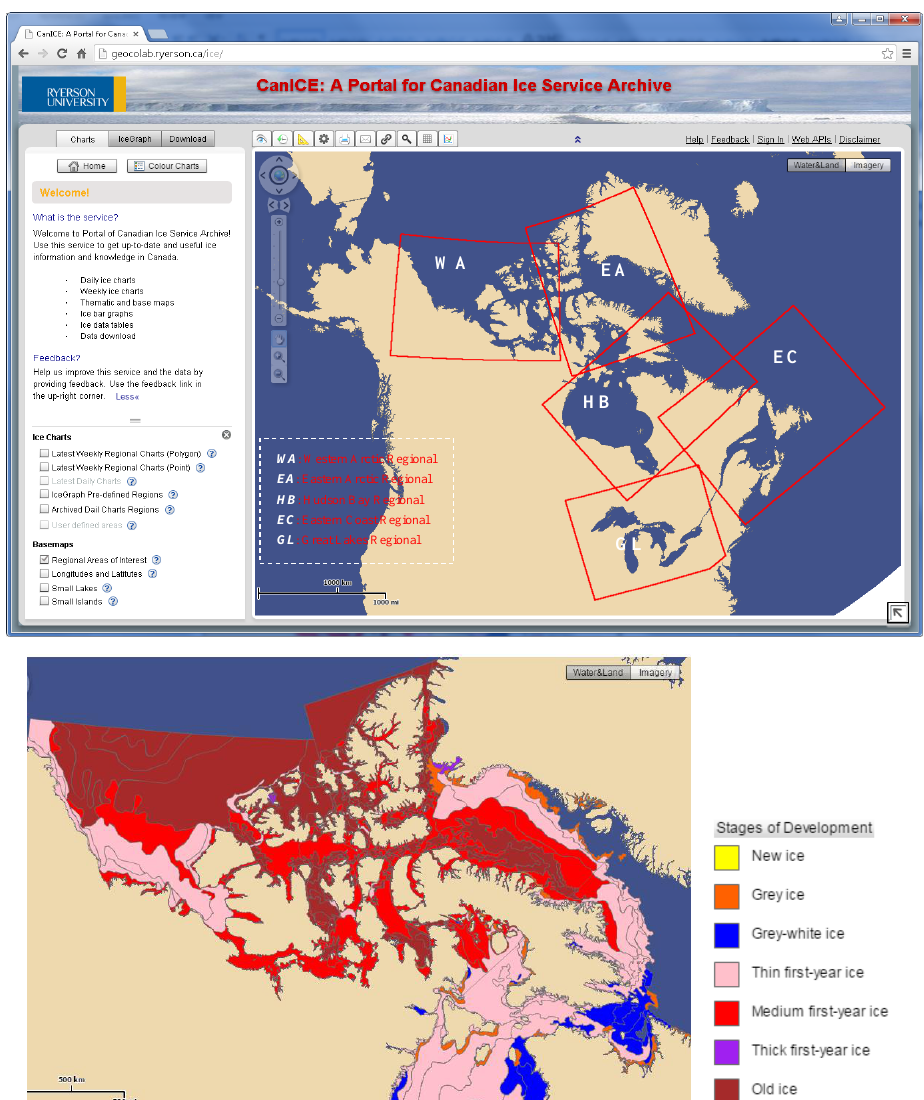
Figure 6. Five regions of interest in the Arctic sea ( upper part ) where digital sea ice charts are available, and an example digital sea ice charts rendered by stages of development ( lower part ). (Source: captured from [29], where two figures are adapted from without copyright